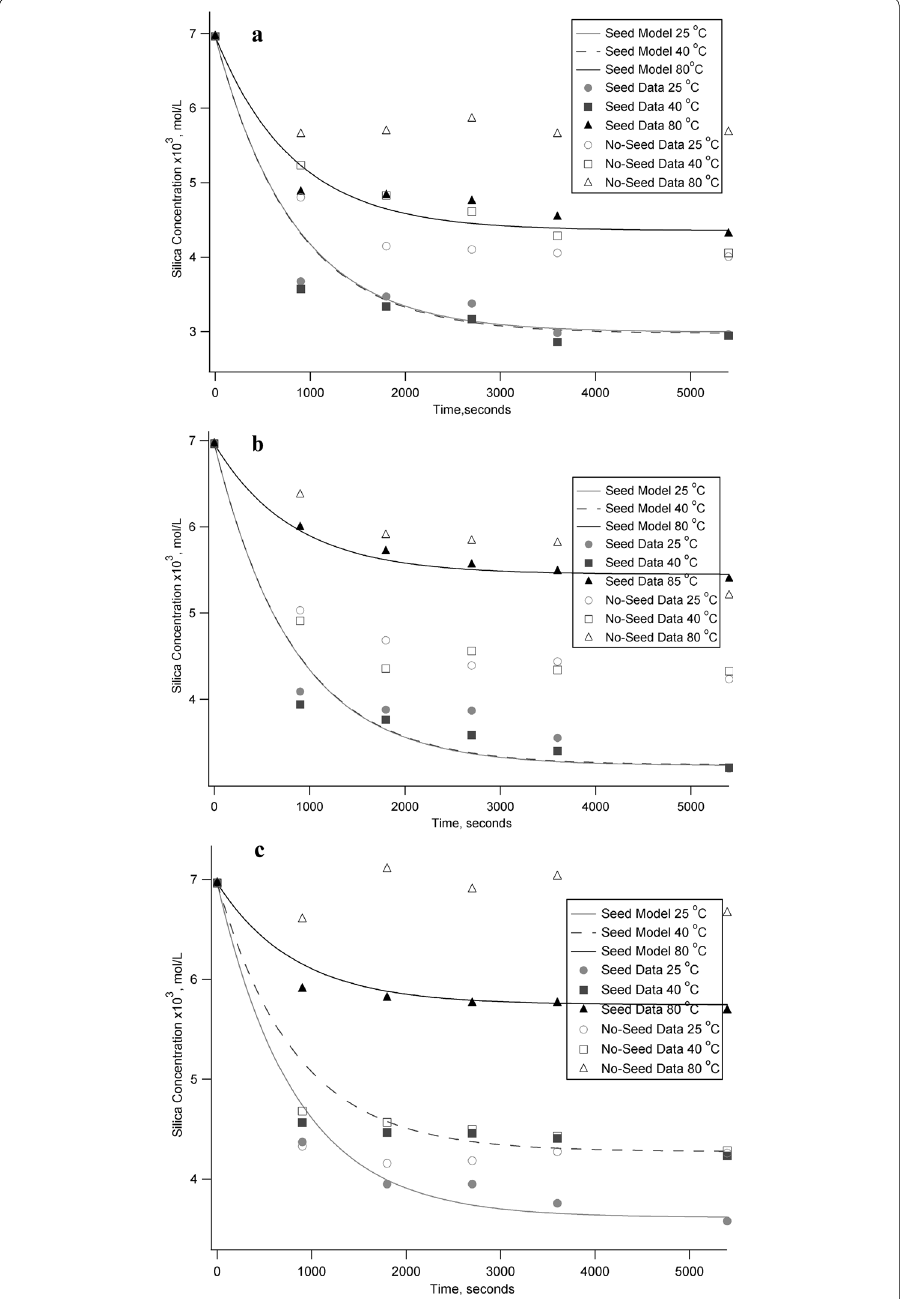
Fig. 3 Silica concentration data and model at various pH and temperatures; a pH 7 at various temperatures, b pH 8 at various temperatures and c pH 9 at various